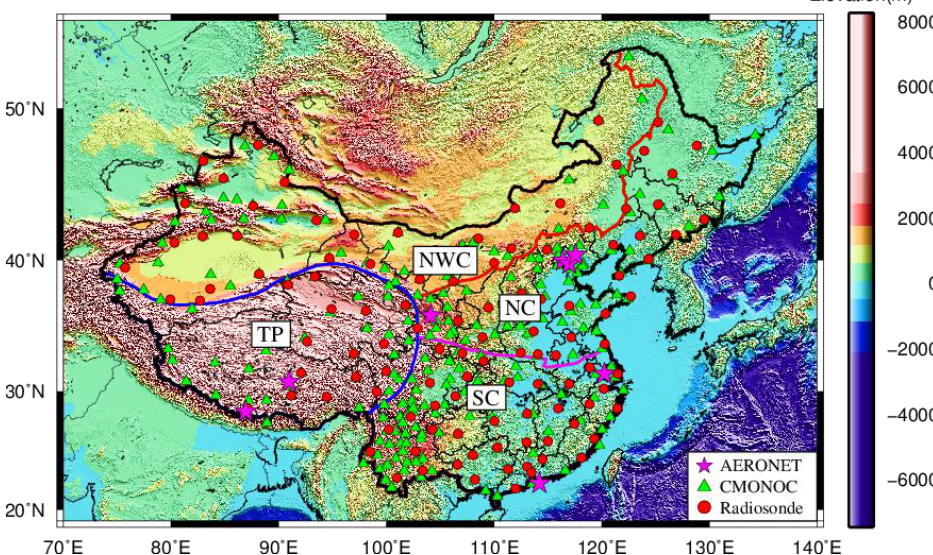
Figure 1. Distributions of AERONET, Crustal Movement Observation Network of China (CMONOC), and radiosonde stations used. The blue, magenta, and red lines denote the boundaries of the four geographical areas.